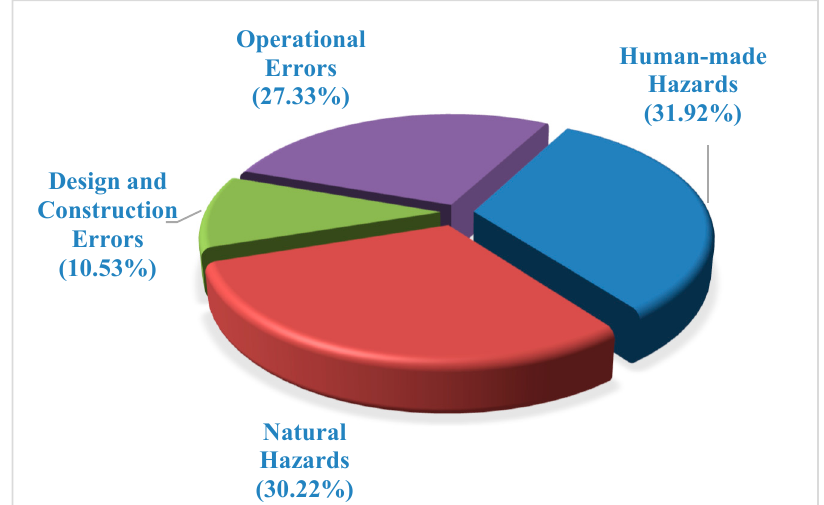
Figure 3. Main causes of failure of existing bridges (1966–2020).